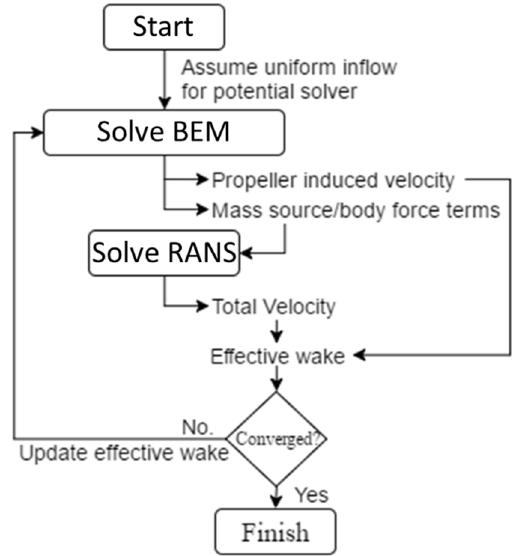
Figure 3. Numerical algorithm of the BEM/RANS 2 interactive scheme.